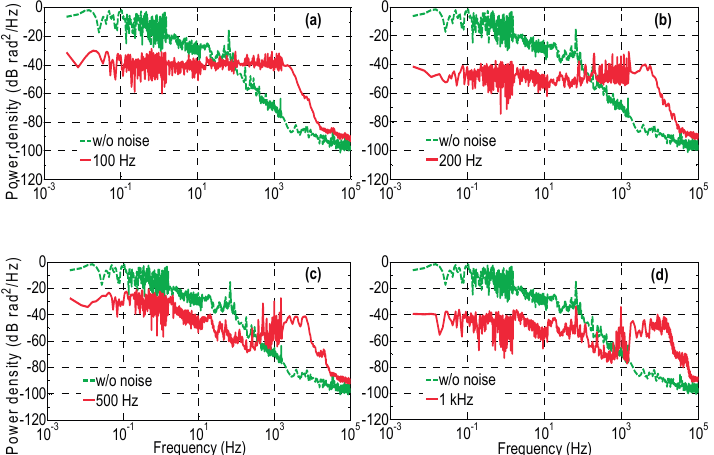
Figure 3. Excess phase noise spectra with (solid) and without (dashed) external acoustic perturbations with 80 m polarization maintaining fiber (PMF) being used. Measurement is done at four single-tone perturbation frequencies: ( a ) 100 Hz; ( b ) 200 Hz; ( c ) 500 Hz; and ( d ) 1